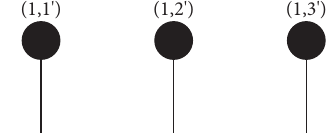
Figure 2: NEPS P